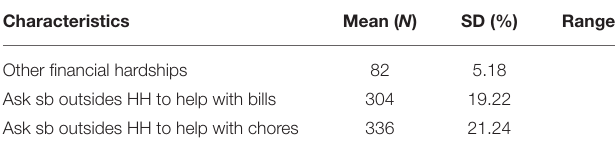
Table 5 focuses on the negative emotional responses among older adults, investigating its relationship with aging attitudes and the vulnerability type. After adjusting for covariates,